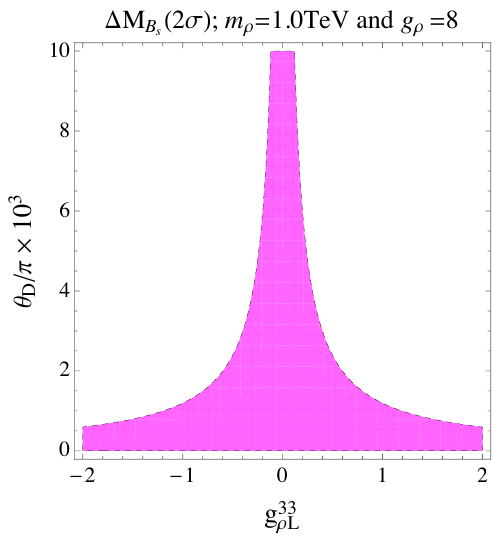
Figure 2 . The (cid:1) M B constraint on the plane ( g 33 ; (cid:18) D ) for m (cid:26) = 1 TeV and g (cid:26) = 8 , where the (cid:26)L s shaded region is allowed at the 2 (cid:27) level read off from eqs. (3.27) and (3.26) with taking into